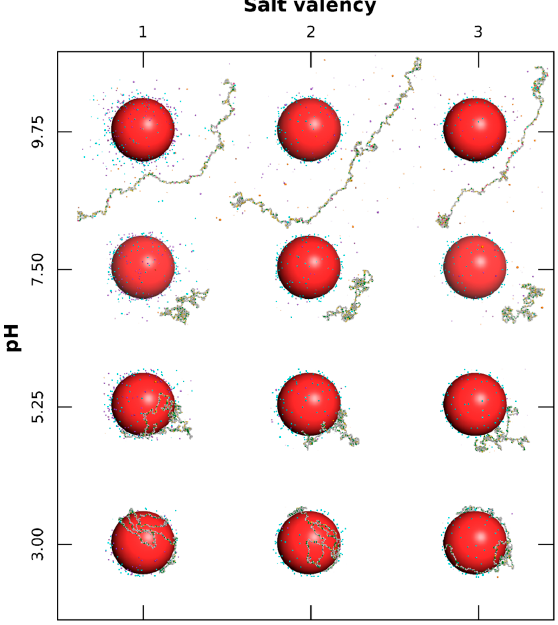
Figure 5. Equilibrated conformations of PP chain in the presence of a NP (100 Å radius) with surface charge density of − 60 mC/m 2 . Each AA can be positive, neutral, or negative (green, grey, and yellow spheres). Monovalent counterions, as well as salt particles with fixed ionic strength of 1 × 10 − 4 M, are considered. The influence of pH variation (3.00 to 9.75) and salt valency (+1, +2, and +3) are specifically studied.